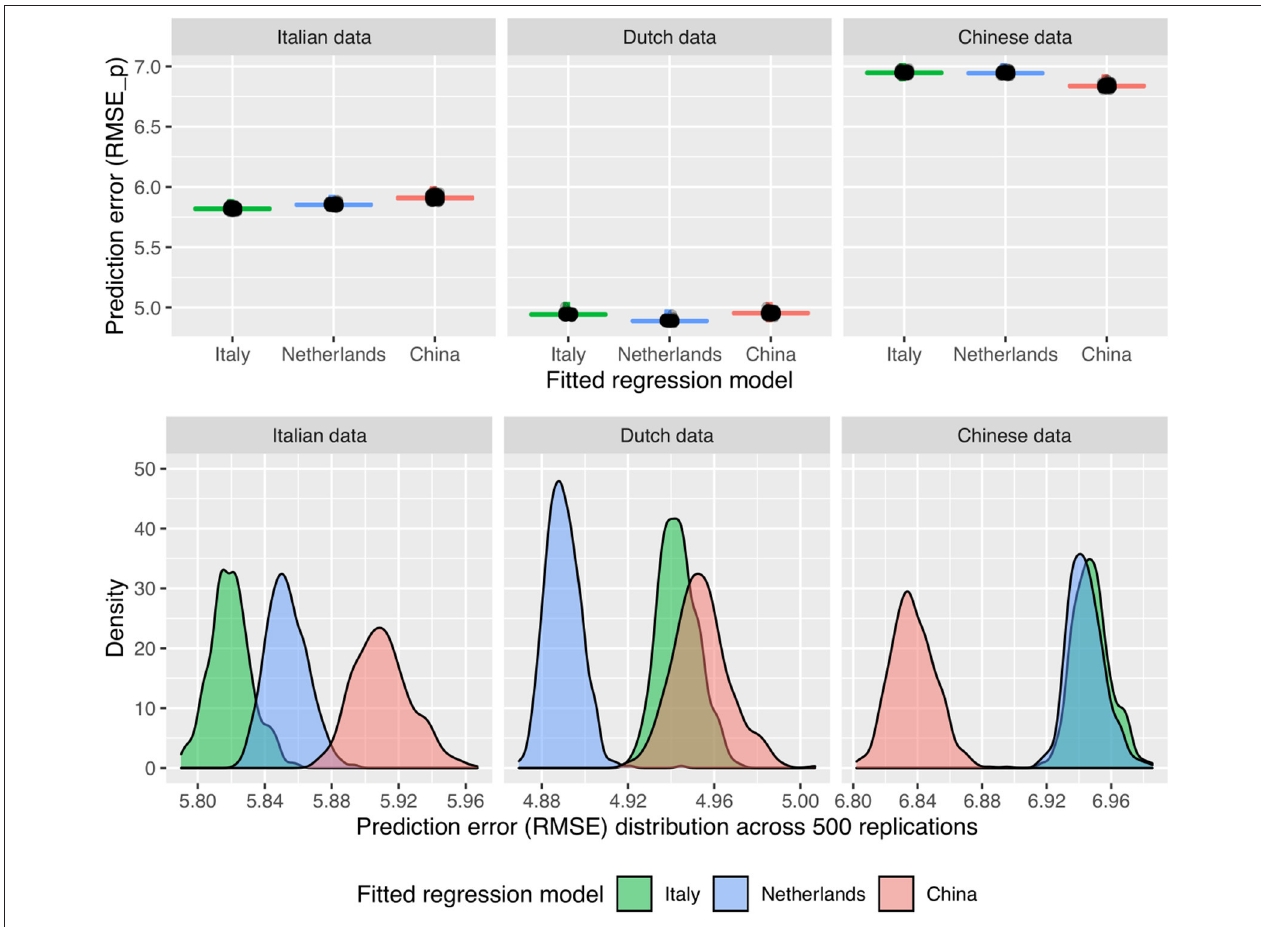
FIGURE 4 | Boxplots (upper row) and density plots (bottom row) showing the distribution of RMSE when fitting each country’s best model to the dataset of each